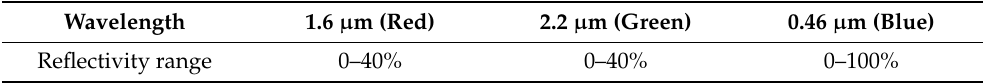
Table 1. The color scheme of RGB composition.